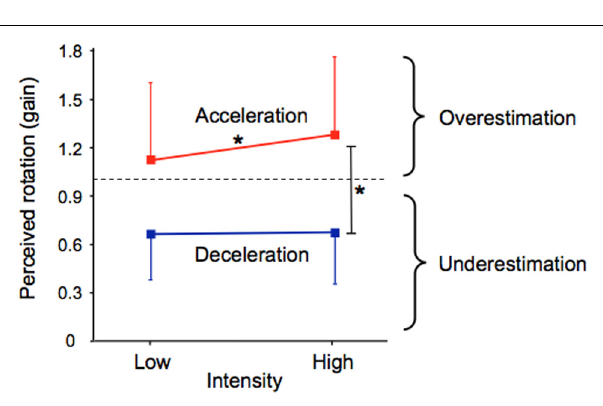
FIGURE 4 | Mean acceleration and deceleration gains as a function of their intensity. The vertical bars represent between-subjects standard deviations. * p < 0.01.